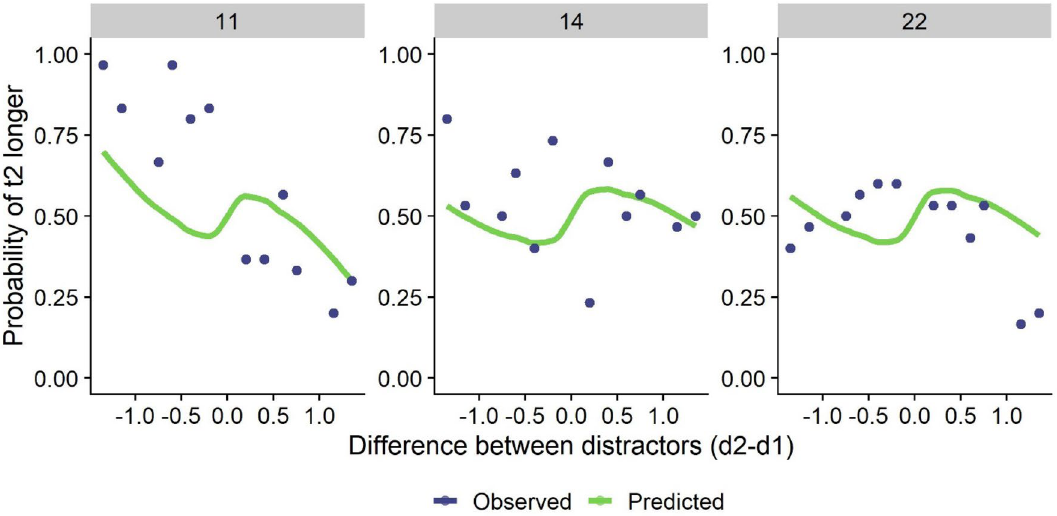
Figure 8. Fit between predicted and observed response probabilities as a function of the difference between distractors for participants with repulsion effect. Predicted probabilities were obtained with the alternative model of lateral inhibition.